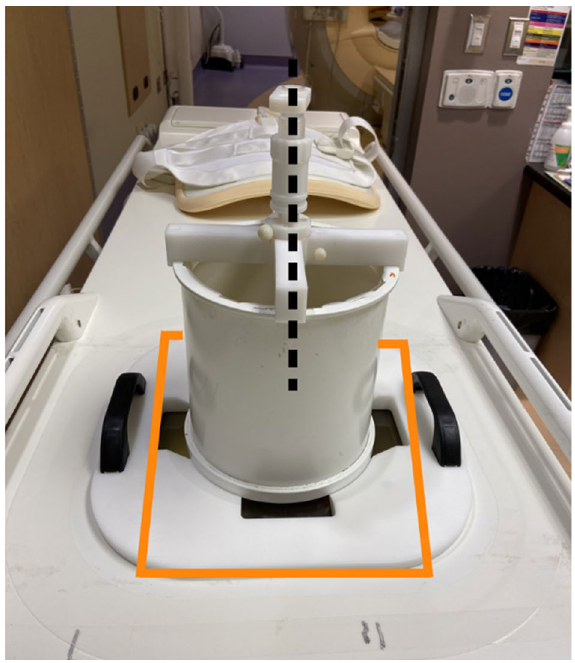
Figure 1. A custom build plastic housing was installed on a hollowed Sonalleve quality control phantom. The dotted black line indicates where a needle hydrophone and wiring could be threaded into degassed water 6 cm above the window membrane (highlighted in yellow).